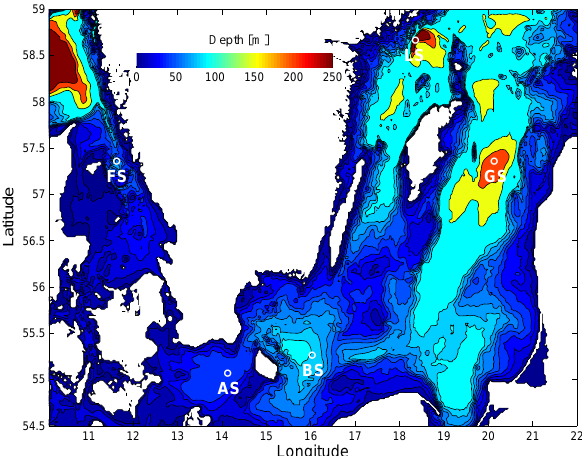
Fig. 1. Map of the Baltic Sea showing the sampling stations: Fladen station (FS), Arkona station (AS), Bornholm station (BS), Gotland station (GS) and Landsort station